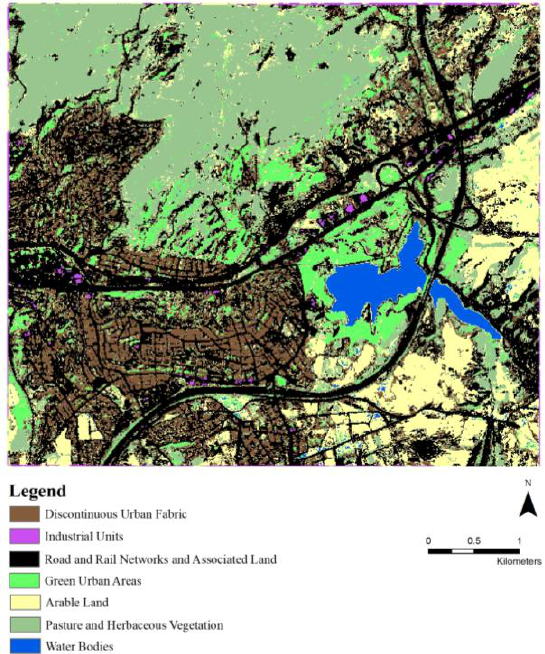
Figure 13. Land use and land cover map of the study area.